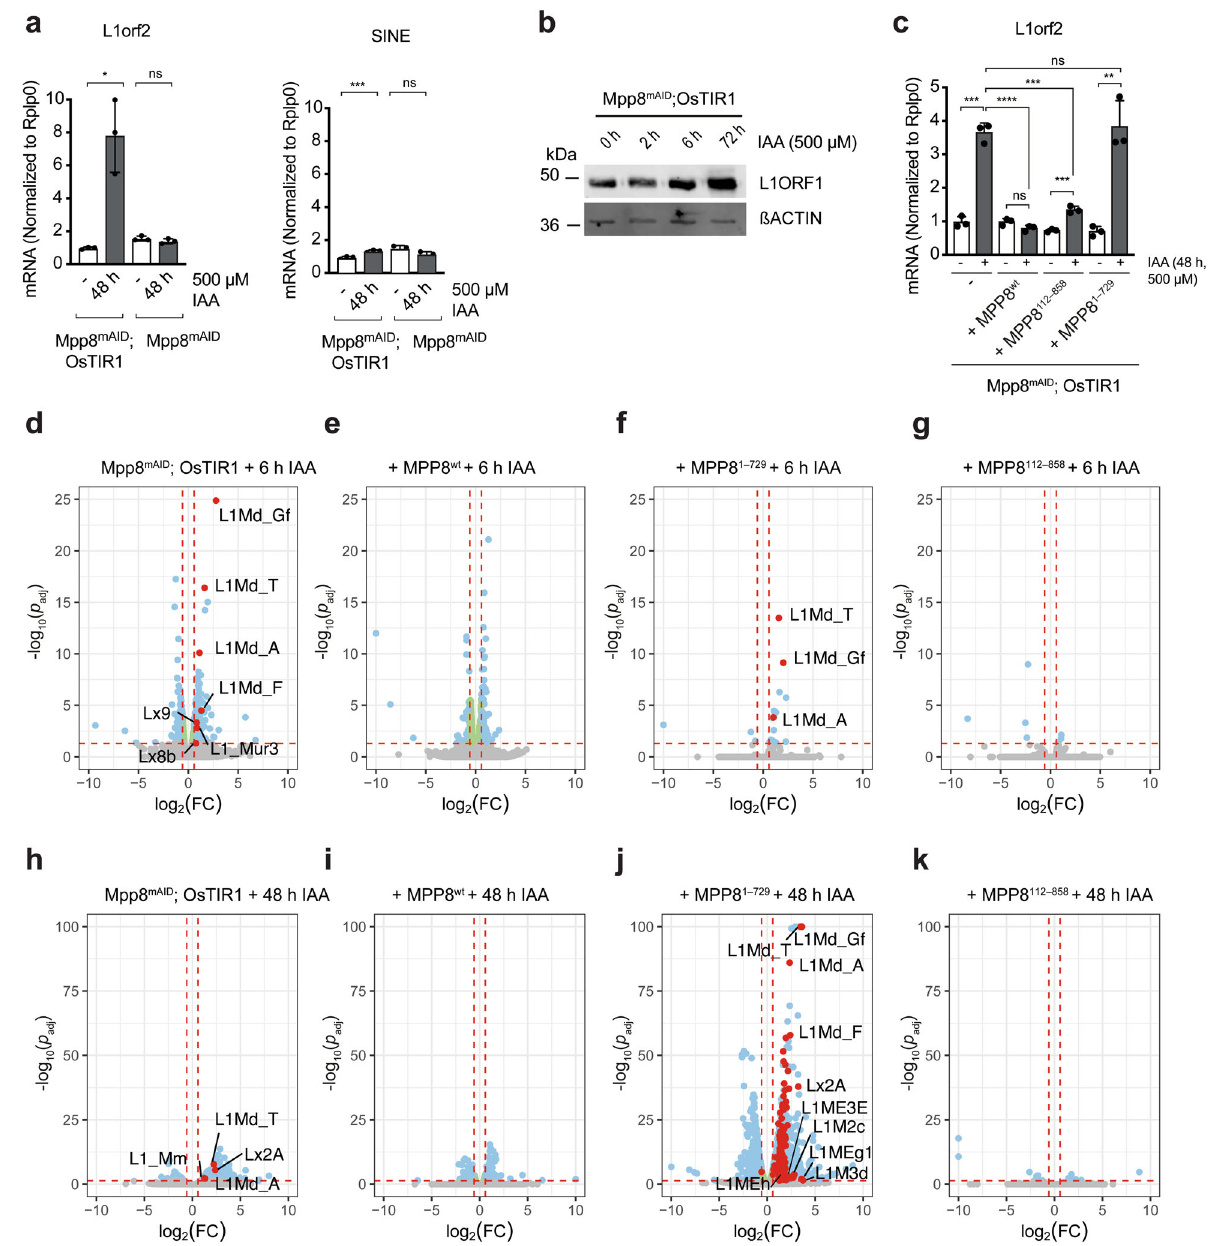
Fig. 5 MPP8 degradation leads to increased LINE1 expression. a qRT-PCR analysis of transcripts encoding LINE1-encoded ORF2 protein or SINEs in Mpp8 mAID ; OsTIR1 or Mpp8 mAID (control) cells grown in 2i/LIF treated with 500 µ m IAA for 48 h (mean± s.d., n = 3 independent experiments). p = 0.0348 (L1orf2) and p = 0.0009 (SINE) for Mpp8 mAID ; OsTIR1 ± IAA and p = 0.3068 (L1orf2) and p = 0.1988 (SINE) for Mpp8 mAID ± IAA (two-tailed paired Student ’ s t test). b L1ORF1 protein expression in Mpp8 mAID ; OsTIR1 cell line grown in 2i/LIF upon IAA treatment and β ACTIN (loading control) ( n = 1). c qRT-PCR analysis of L1orf2 transcript, encoding LINE1-encoded ORF2 protein, transcript expression in Mpp8 mAID ; OsTIR1 cells grown in 2i/LIF stably expressing MPP8 wild-type, indicated MPP8 mutant, or no additional cDNA treated with 500 µ m IAA for 48 h (mean± s.d., n = 3 independent experiments). p = 0.0093 ( − ), p = 0.1973 (wt), p = 0.0089 (112 – 858) and p = 0.0139 (1 – 729) for indicated cells ± IAA (two-tailed, paired Student ’ s t test) and p = 7.900E-05 (wt), p = 0.0002 (112 – 858) and p = 0.7296 (1 – 729) comparing the indicated auxin-treated cell line to auxin-treated Mpp8 mAID ; OsTIR1 cells (two-tailed, unpaired Student ’ s t test). d – k Volcano plots presenting differentially regulated transcripts upon treatment with 500 µ M IAA for 6 h ( d-g ) or 48 h ( h – k ) in Mpp8 mAID ; OsTIR1 cells grown in 2i/LIF stably expressing MPP8 wild-type and indicated MPP8 mutants as assessed by RNA-seq. Dashed red lines: p adj < 0.05, |FC| > 1.5. Red dots: signi fi cantly changed LINE1 classes. Blue dots: Signi fi cantly changed transcripts ( p < 0.05, |FC| > 1.5). Green dots: Signi fi cant changes with |FC| < 1.5. Gray dots: Not signi fi cant ( n = 2 biologically independent samples). In ( j ) the top ten differentially expressed LINE1 classes based on fold change are highlighted. For visualization purposes, transcripts surpassing |log 2 FC| > 10 or − log 10 ( p adj ) > 100 are plotted as |log 2 FC| = 10 or − log 10 ( p adj ) = 100, res p ectively. * p < 0.05, ** p < 0.01, *** p < 0.001, **** p < 0.0001, ns = not signi fi cant, FC = fold change. Source data are provided as a Source Data fi